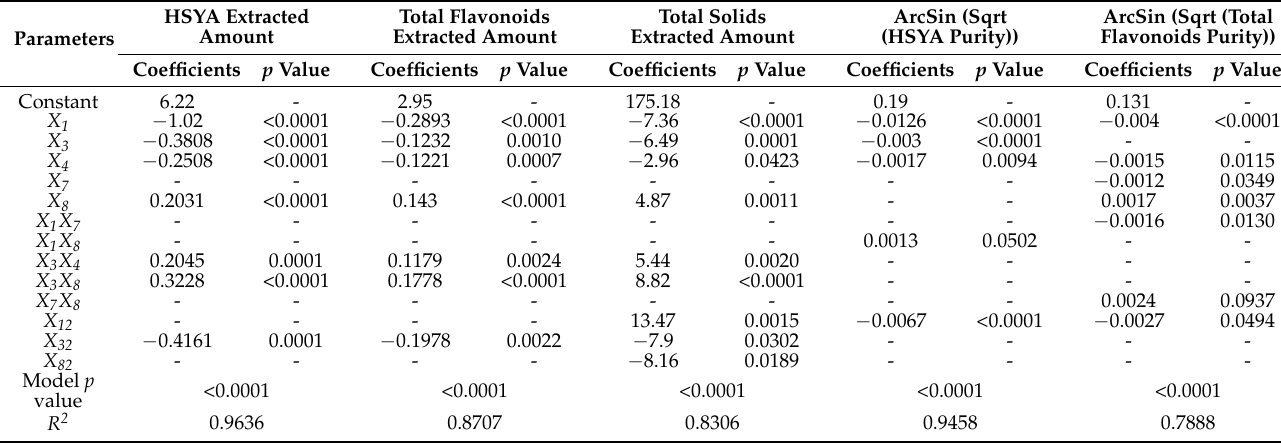
Table 4. Regression coefficients and variance analysis of regression model after continuous improvement.